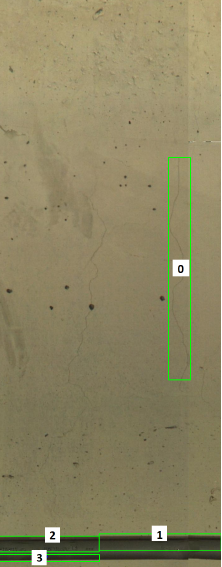
Figure 16. The change candidates corresponding to the example in Figure